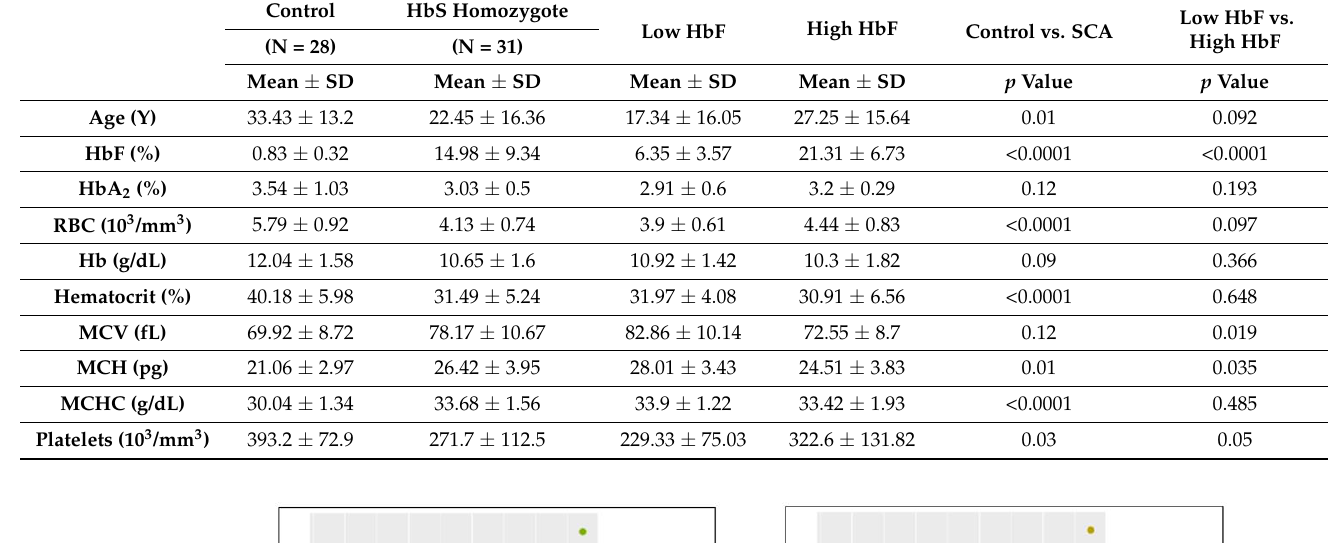
Table 1. Baseline characteristics and hematological parameters.